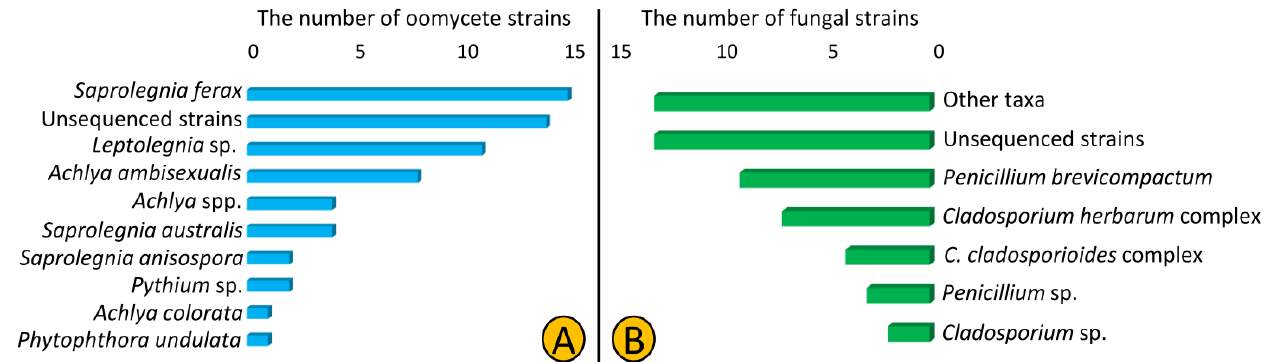
Figure 1. Composition of oomycete (Saprolegniales and Peronosporales) ( A ) and fungal ( B ) taxa isolated from 12 lakes of Northeast Germany in 2018.